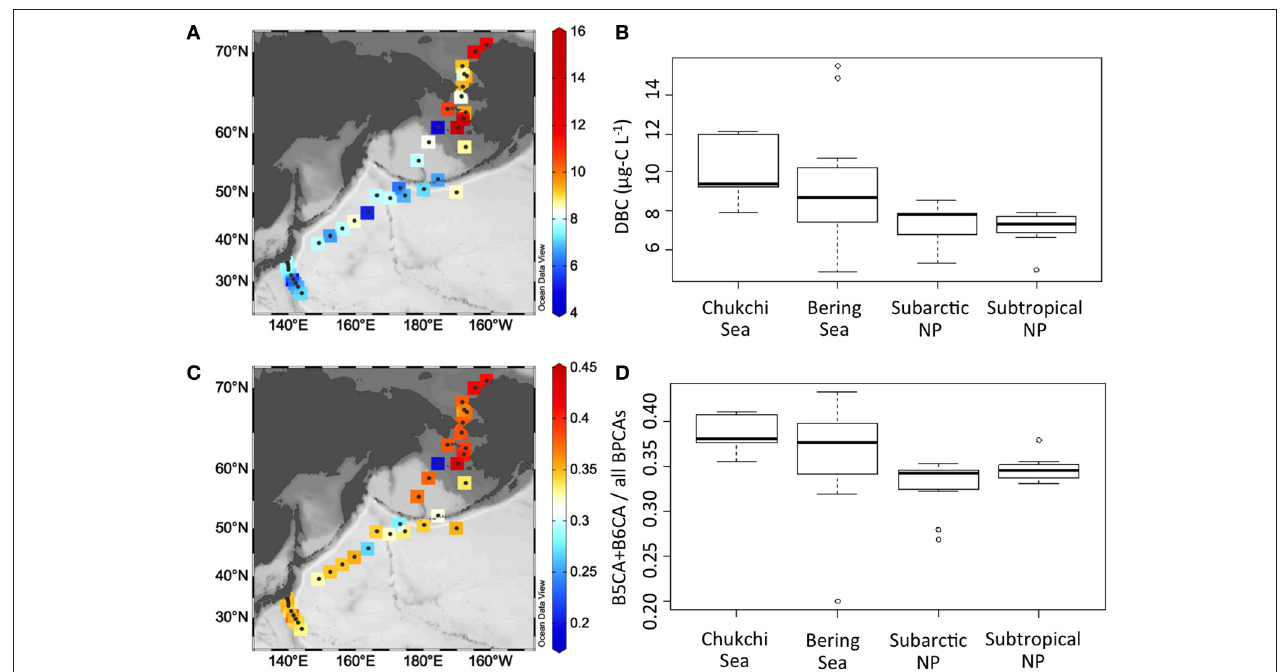
FIGURE 4 | Spatial distributions of DBC concentration (A) and condensation degree (ratio of B5CA and B6CA to all BPCAs) of DBC (C) , and box and whisker plots of DBC concentration (B) and condensation degree of DBC (D) in surface waters of the Chukchi/Bering Seas, the subarctic and the subtropical North Pacific (NP). In box and whisker plots, the central bold line represents the median of the dataset. The upper and lower ends of the box represent the first and third quartiles of the dataset, respectively. The upper and lower whiskers represent the dataset maximum and minimum, respectively. The open circle represents the outlier (more than 2 standard